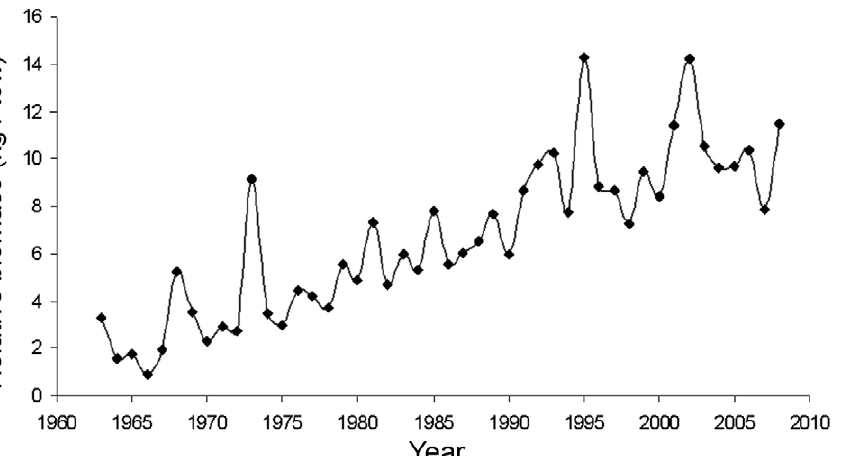
Figure 8. Interannual variation in the relative biomass of the major small pelagic fishes in the Gulf of Maine region. Adapted from [32].